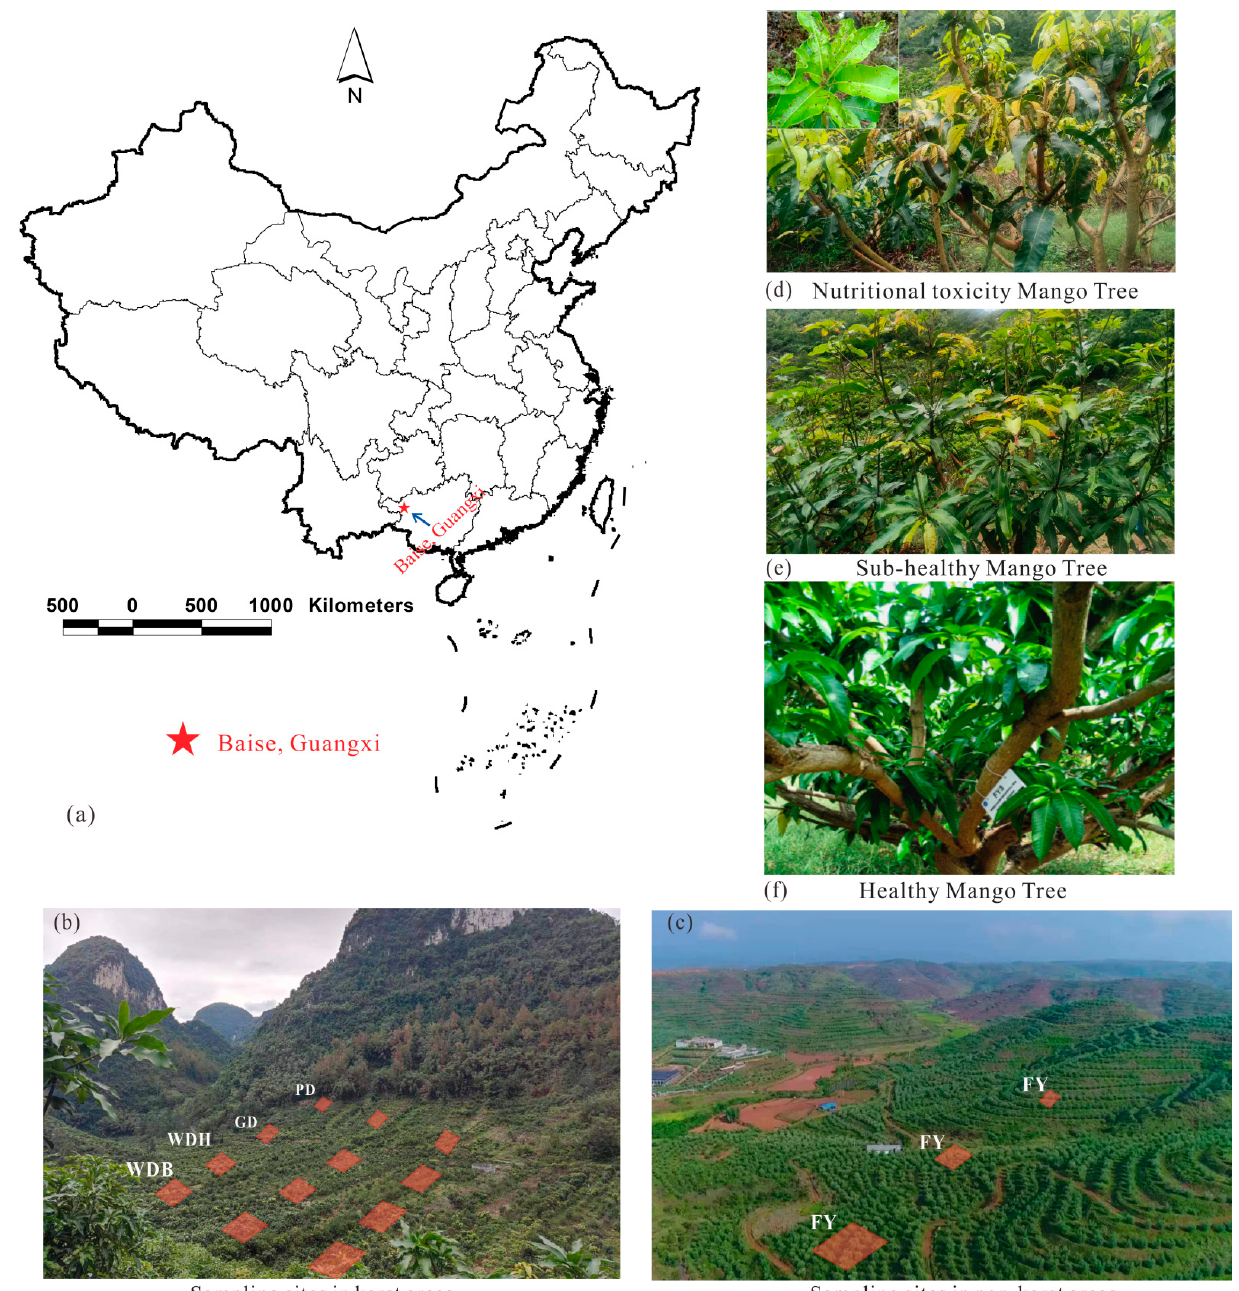
Figure 1. ( a ). The geographical location of the study area; ( b ). The sampling sites in karst areas; ( c ). The sampling sites in non-karst areas; ( d ). Nutritional toxicity mango tree; ( e ). Sub-healthy mango tree; ( f ). Healthy mango tree. mango tree; ( f ). Healthy mango